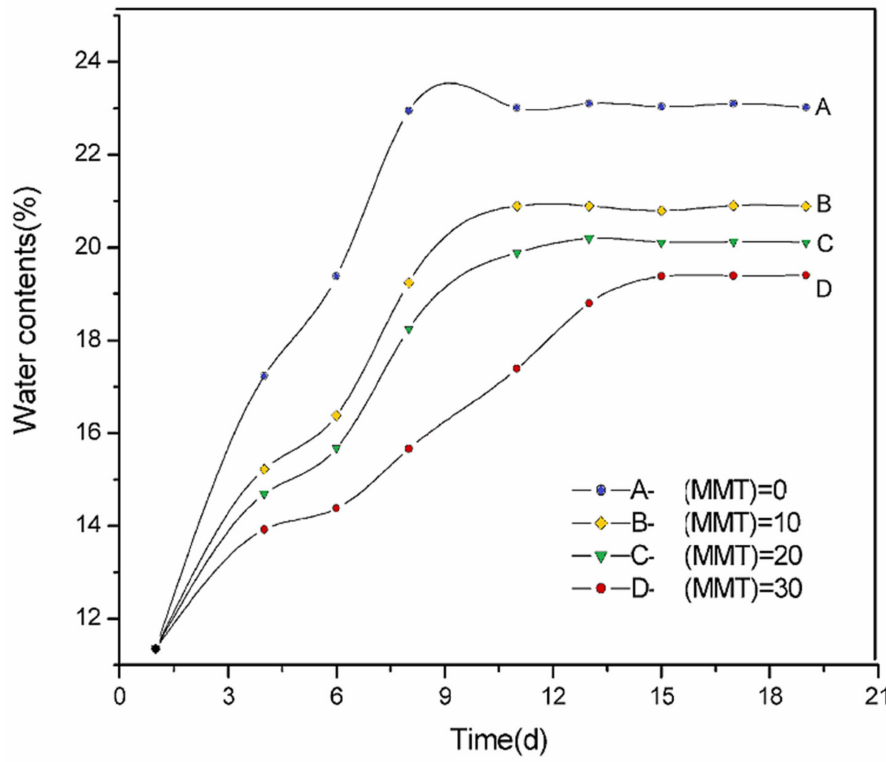
Figure 21. Water content of nanocomposites at 50% RH for different MMT in wt % (0, 10, 20, 30). Reproduced with permission from Polymer ( Guildf )., 45 , Huang et al., Studies on the properties of montmorillonite-reinforced thermoplastic starch composites, 7017–7023, 2004 [158]. In terms of optical properties, incorporating MMT in the TPS matrix decreases the luminosity and transparency due to the increase in light dispersion and diffuse reflectance, resulting in an opaquer nanocomposite. This behavior is highlighted by using rosemary essential oil (as an antioxidant) studied by Azevedo et al. [43] in corn TPS. It occurs due to a possible light scattering in the interface of oil